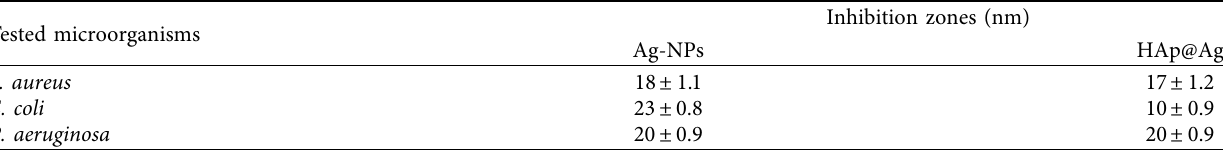
Values of three replicates are expressed as mean ± SD (standard